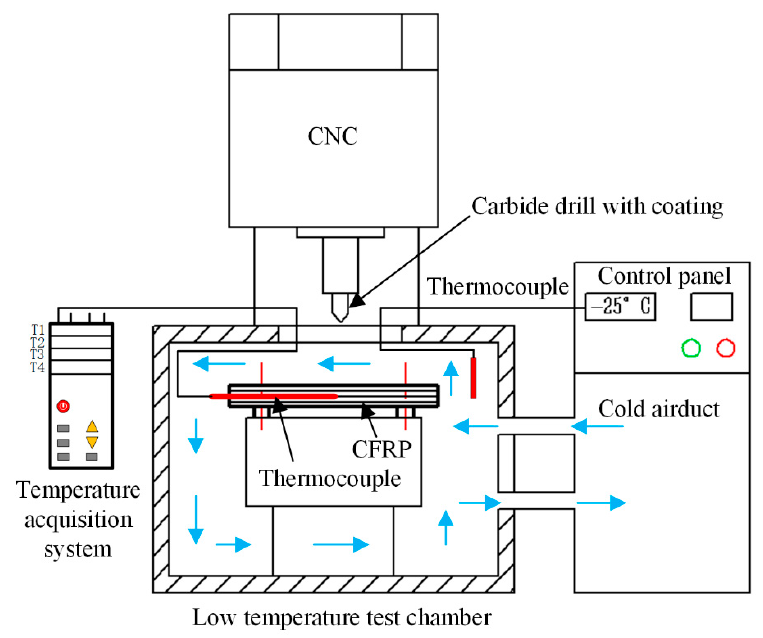
Figure 2. Schematic illustration of the temperature-controlled drilling experiment setup.